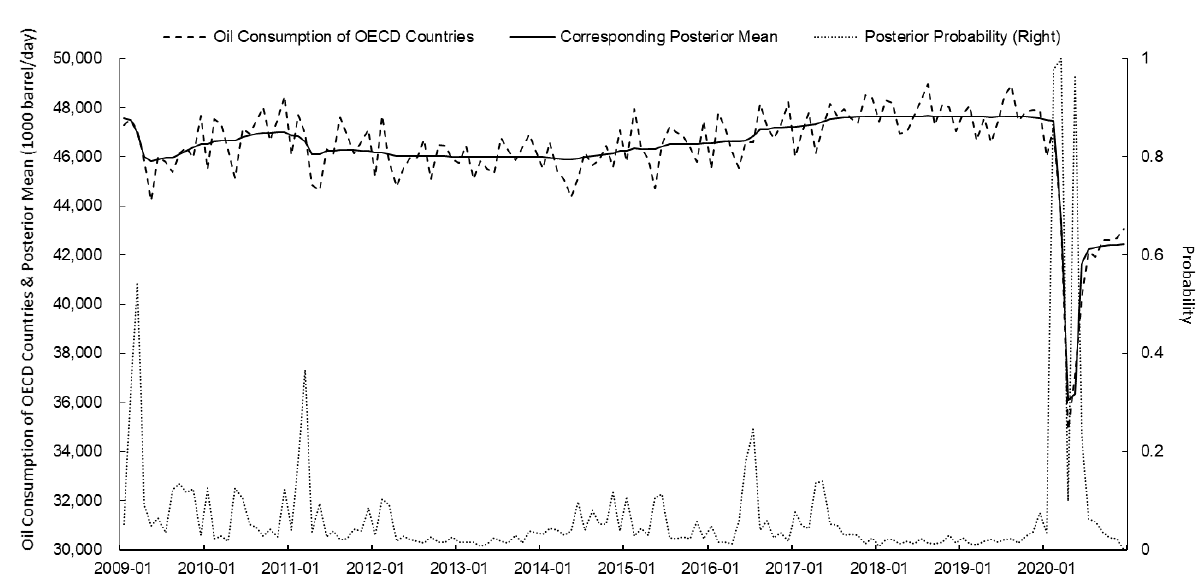
Figure 3. PPM calculation results of global oil production and corresponding posterior mean and posterior probability since 2009 (source: EIA).